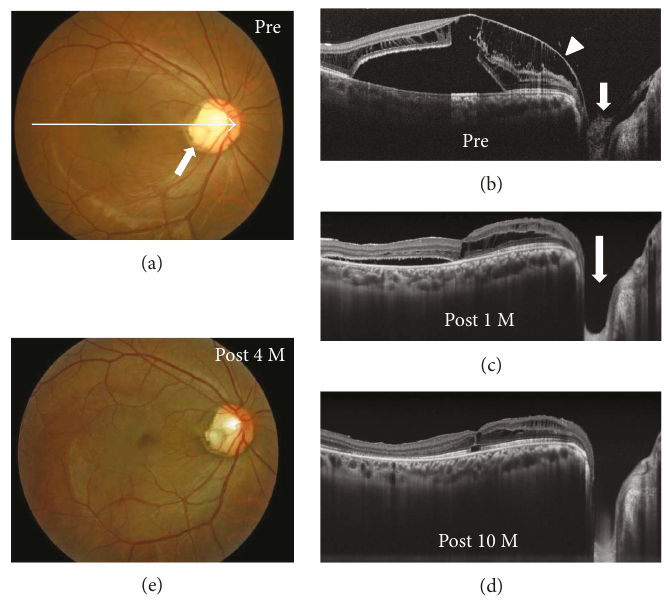
Figure 2: Photographs of the right eye in a 24-year-old optic disc pit (ODP) maculopathy patient without posterior vitreous detachment (case 2). (a) Fundus photograph before surgery showed an ODP (arrow) and macular retinal elevation. An arrow indicates enhanced depth imaging optical coherence tomography (EDI-OCT) scans for the images shown in Figure 2. (b – d) EDI-OCT images. Before surgery, retinal schisis extended from the optic disc to the macula with macular detachment (b). Glial tissue suggests that the Cloquet ’ s canal (b, arrow) was also present, invaginating into the ODP and the hyaloid membrane attached to the glial tissue (b, arrowhead). The retinal schisis was reduced 1 month after pars plana vitrectomy (c) and was almost resolved with foveal attachment 10 months after surgery (d). The epipapillary membrane tissue was also removed (c, arrow). (e) The retinal elevation was reduced at four months after